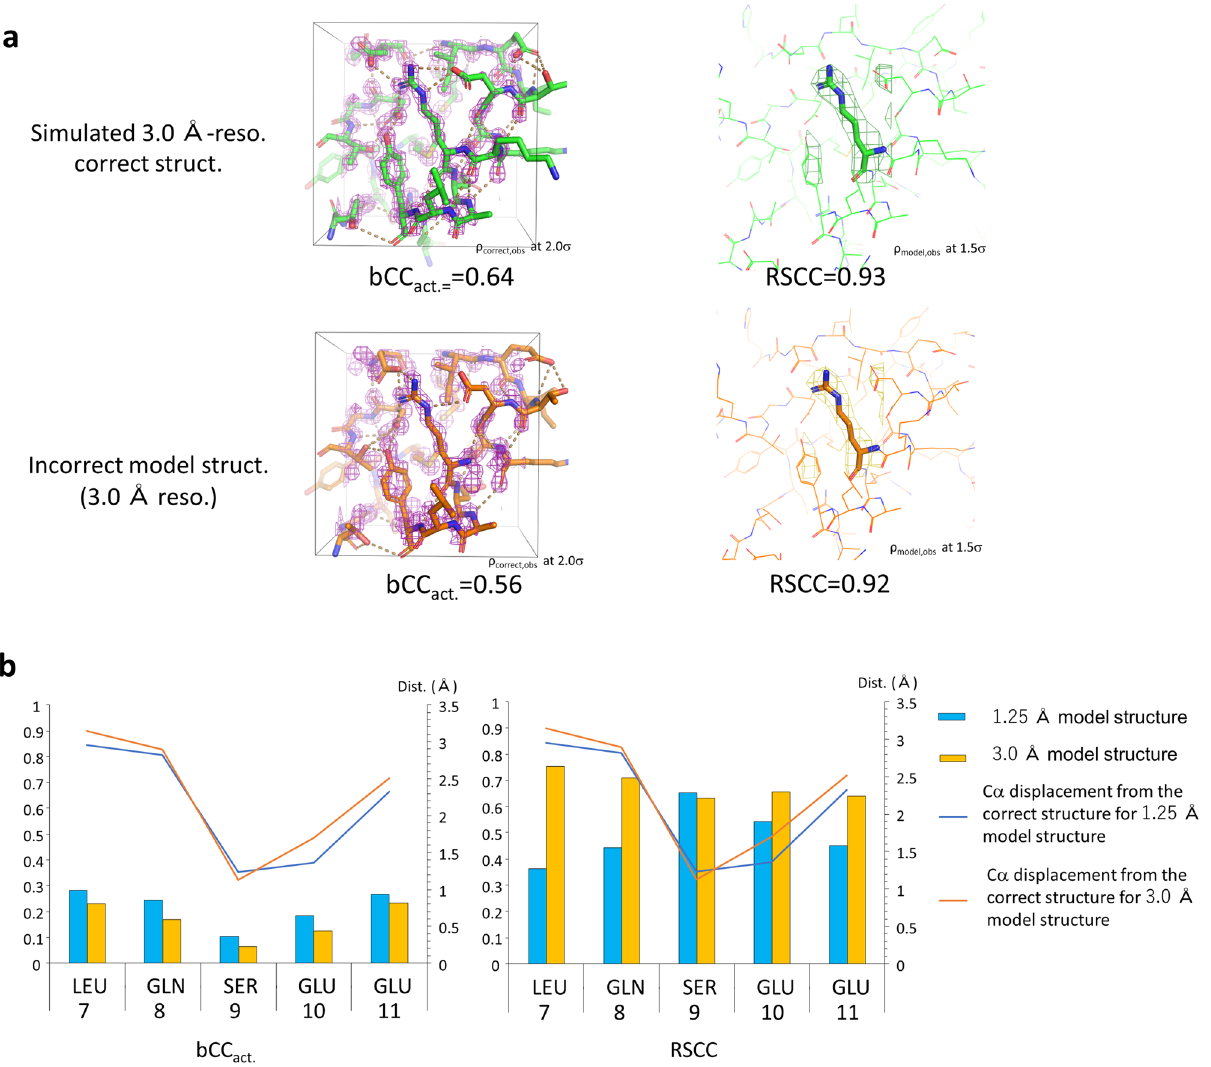
Figure 3. bCC and RSCC. ( a ) Arg67 of 3F9X (molecule D) in the correct and incorrect model structures. The template of homology modeling for the incorrect structure was 1ZKK. Electron densities used for the calculation of bCC (left) and RSCC values (right) are also shown. Values of bCC include the environment surrounding Arg67 (left), while RSCC measured correlation electron density covering Arg67 and its atoms (right). ( b ) Comparison of bCC and RSCC in the region where the main chain is completely misplaced from the correct electron density map. The bCC (left) and RSCC (right) values at residues 7–11 of the model structure at 1.25 Å- and 3.0 Å-resolution structures of 3F9X. The template of homology modeling for the incorrect structure was 5V2N. All the Cα atoms of the region are more than 1 Å away from the corresponding Cα atom of the correct structure. Because bCC is not affected by model bias, no residue is correlated with the correct electron density (bCC < 0.3). Contrastingly, because RSCC is affected by model bias and large B-factors, it shows correlation with electron density, and the effect is larger at 3.0 Å resolution. The electron density maps and coordinates are shown in Supplementary Fig. terminal residues, no residue exceeded the correct structure’s bCC pred. , and the structure with the maximum bCC pred. was the correct structure, as expected. The model structures had conformational errors at α1–3, and the bCC act . values were as low as 0.2–0.4 (Fig. 5b and Supplementary Fig. S5). Most of the bCC pred . values were 0.4 or less, implying that they were precisely pre- dicted and not correlated with the correct electron density. The bCC values of the region of Fig. 3b were also predicted, and no correlation with the high-resolution electron density was predicted (bCC preds. < ~ 0.4) cor- rectly (Fig. 5c). However, the bCC pred. value of some residues was as high as 0.6, which is approximately 0.2-fold higher than that of bCC act. , and these structures were predicted to be well-correlated with the correct structure, despite the main chain being incorrect [e.g., for the 1.25 Å resolution structure of Ile154, bCC act. = 0.395 and bCC pred. = 0.668, and for the 3.0 Å resolution structure of Lys150, bCC act. = 0.315 and bCC pred. = 0.583 (Supple- mentary Fig. S5)]. This problem should be considered and solved as follows.